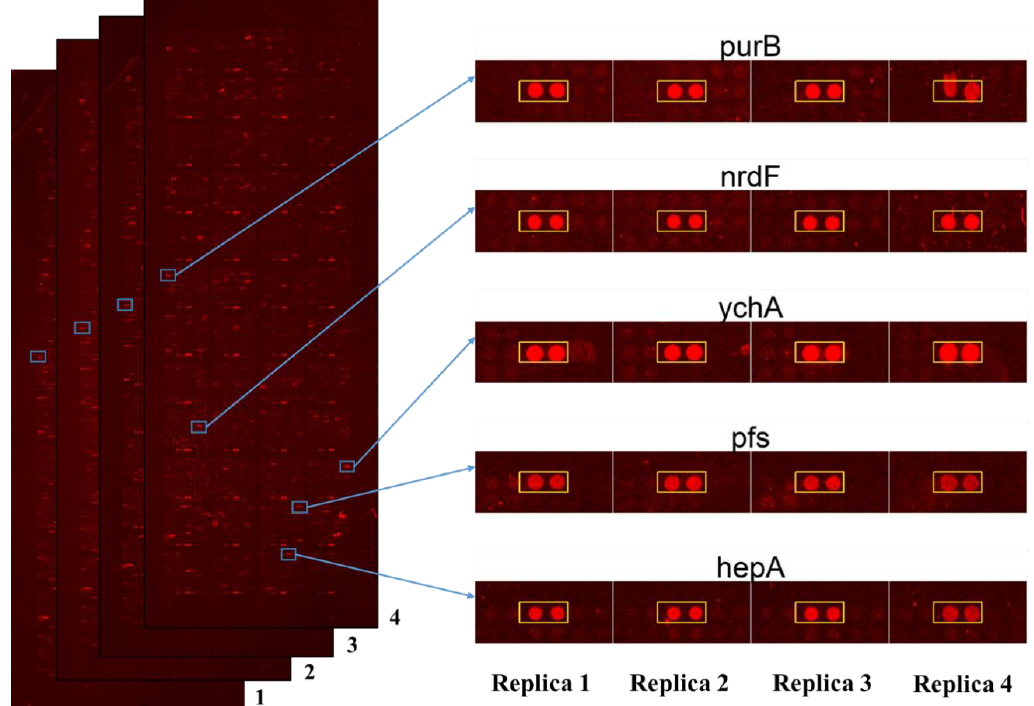
Figure 2. Images of Escherichia coli proteome microarrays and the representative protein targets of polyphemusin-I. The scan images of quadruplicate Escherichia coli proteome microarrays (numbered as 1, 2, 3 and 4) probed with polyphemusin-I ( left ). The enlarged images of representative protein targets of polyphemusin-I from quadruplicate Escherichia coli proteome microarrays ( right ). Each red spot (in duplicate) inside the square box represents the individual protein target of polyphemusin-I identified individually from four Escherichia coli proteome microarrays. Four replicated assays of Escherichia coli proteome microarrays with polyphemusin-I are represented by replicas 1, 2, 3 and 4, respectively.